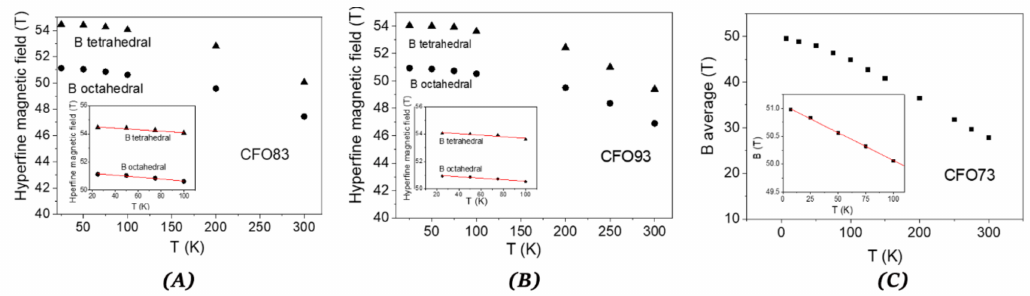
Figure 9. Thermal dependence of the hyperfine magnetic field for CFO83 ( A ), CFO93 ( B ), and CFO73 ( C ).